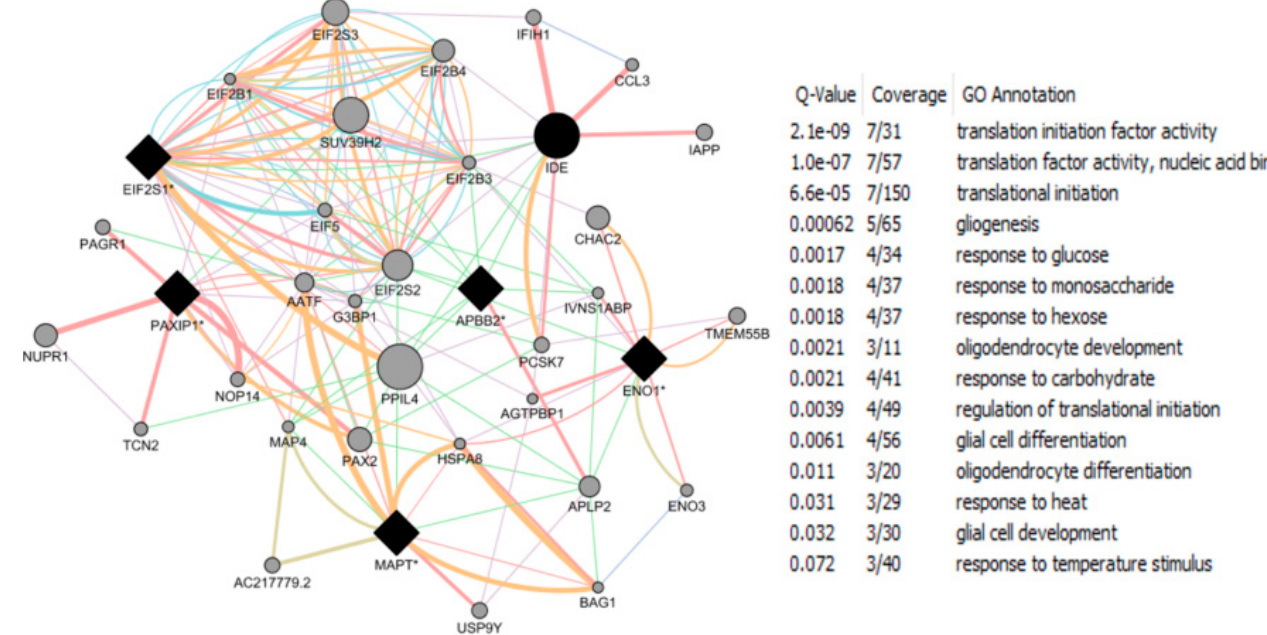
Figure 5. Gene set pathway enrichment analysis of ethinyl estradiol responsive E2 and NRF1 common target genes associated with Alzheimer’s Disease (AD). The network includes the top 30 ethinyl estradiol-associated genes in AD in gray. Ethinyl estradiol responsive NRF1 genes are in black and * genes denoted by a diamond-shaped node are E2 and NRF1. Right panel show GO annotations of E2 and NRF1 enrichment network genes of ethinyl estradiol associated with biological process pathways involving multiple E2 and NRF1 genes and Q -value as a probability showing number of genes out of the total genes annotated to each GO term.